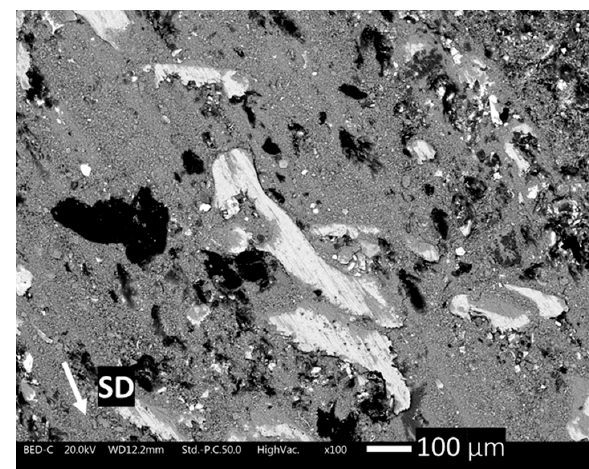
Figure 8. SEM images of the sliding surface of the rectified, scorched and extra-scorched samples ran with the PoD. The sliding direction (SD) during testing is marked with arrows.